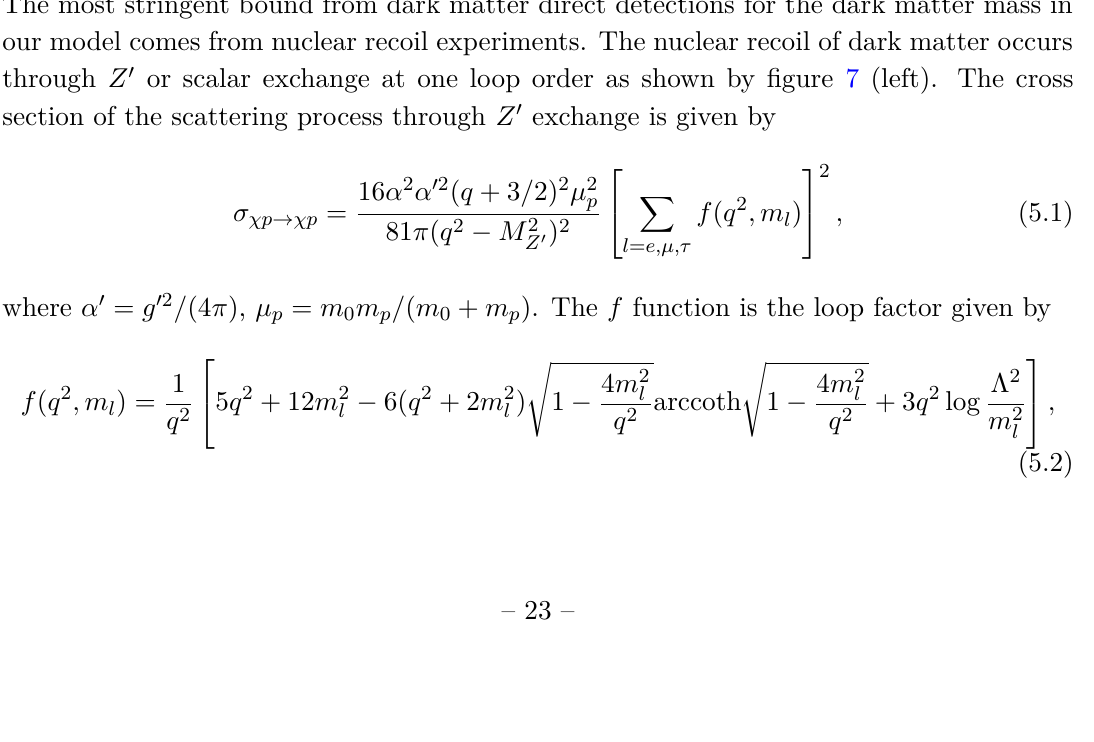
Figure 6. Benchmark points producing the observed baryon asymmetry, and the correct dark matter relic density, projected in the dark gauge parameter space defined by g 0 and M points are excluded by LEP constraints — the main collider constraint in this mass region. Red and cyan points survived collider searches, although the latter are excluded by direct dark matter detection